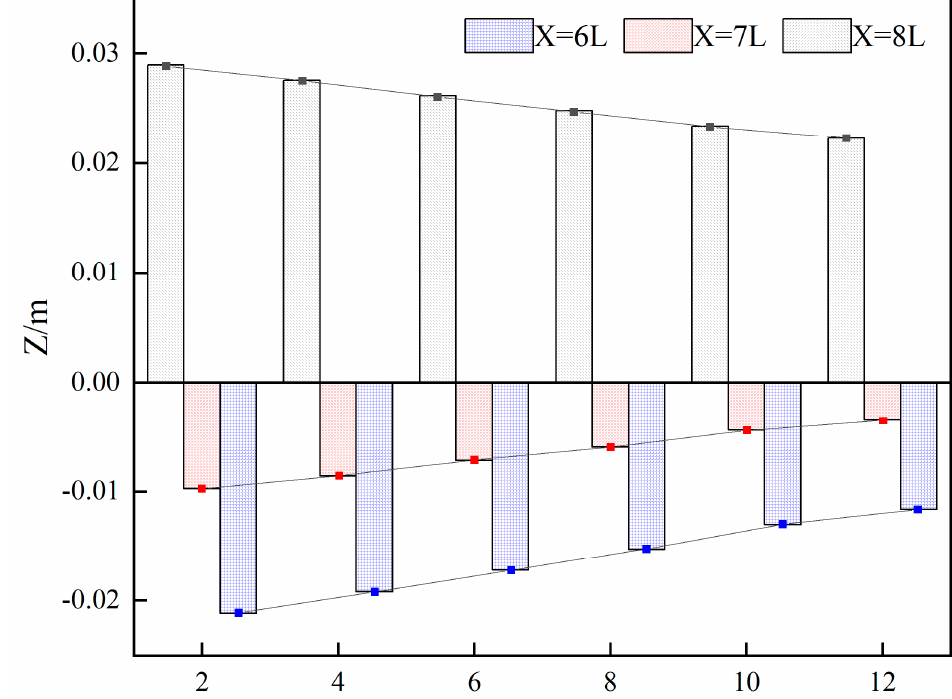
Figure 15. Wave height value at the punctuation point of the cross